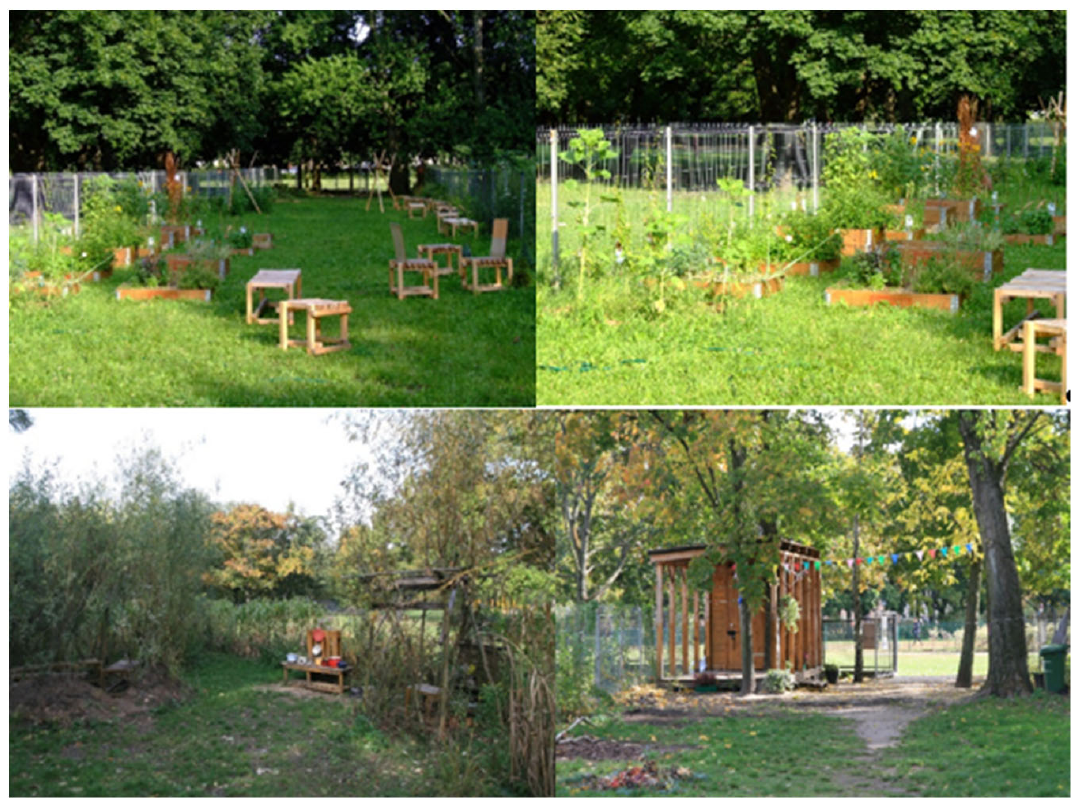
Figure 3. Collective K ą pielisko Community Garden, Pozna ń (Agnieszka Antonowicz 2014).